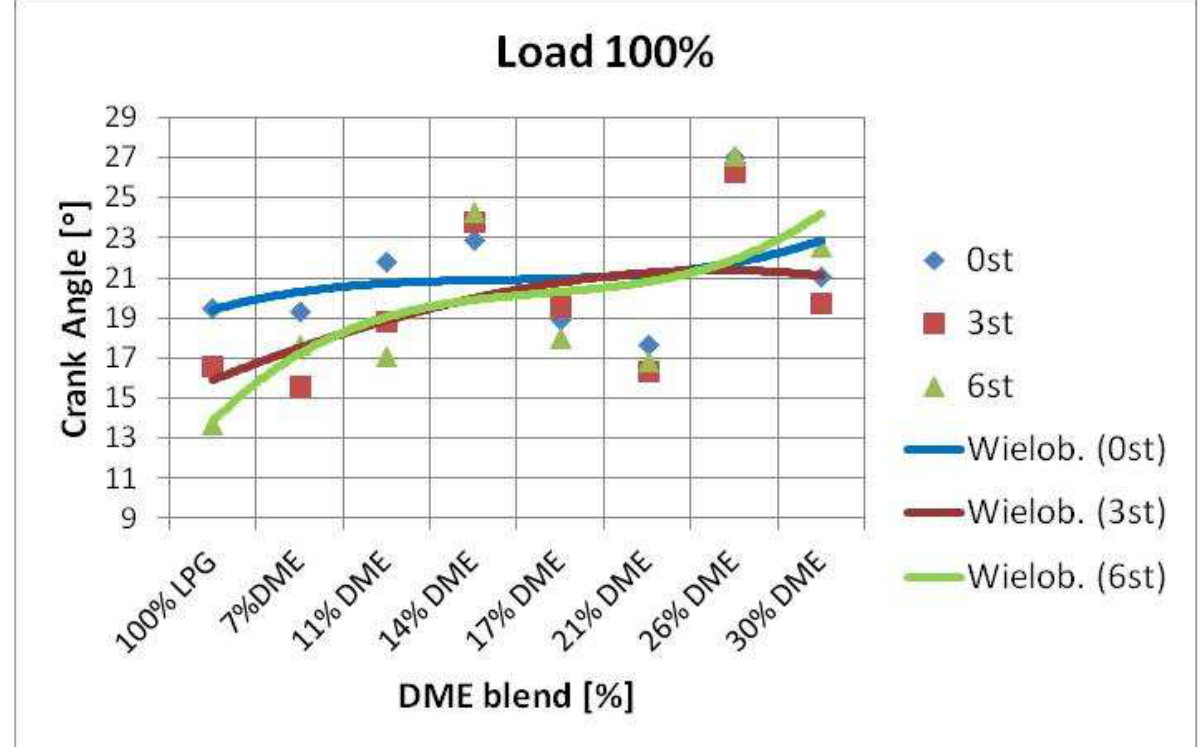
Figure 10. Change of maximum in-cylinder pressure angle vs. RPM.